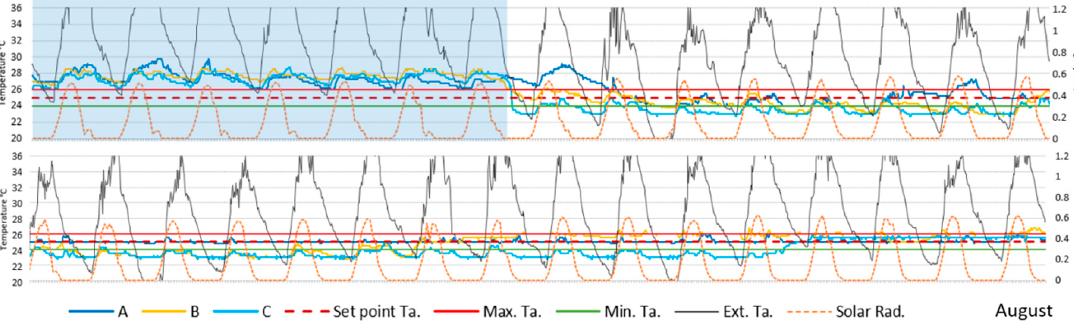
Figure 7. Interior and exterior temperature data and global solar radiation data for August 2018.